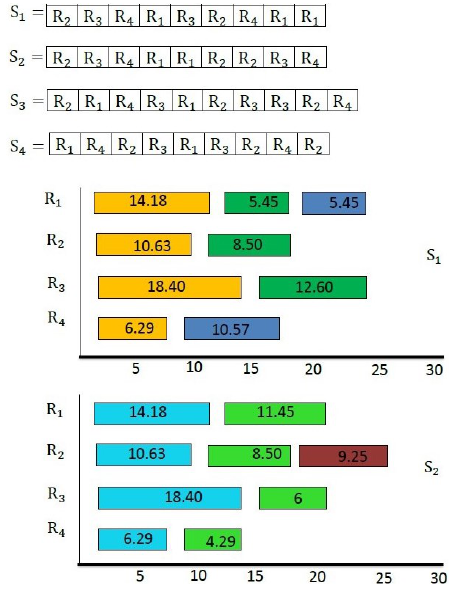
Figure 6. Corresponding Gantt chart of S 1 and S 2